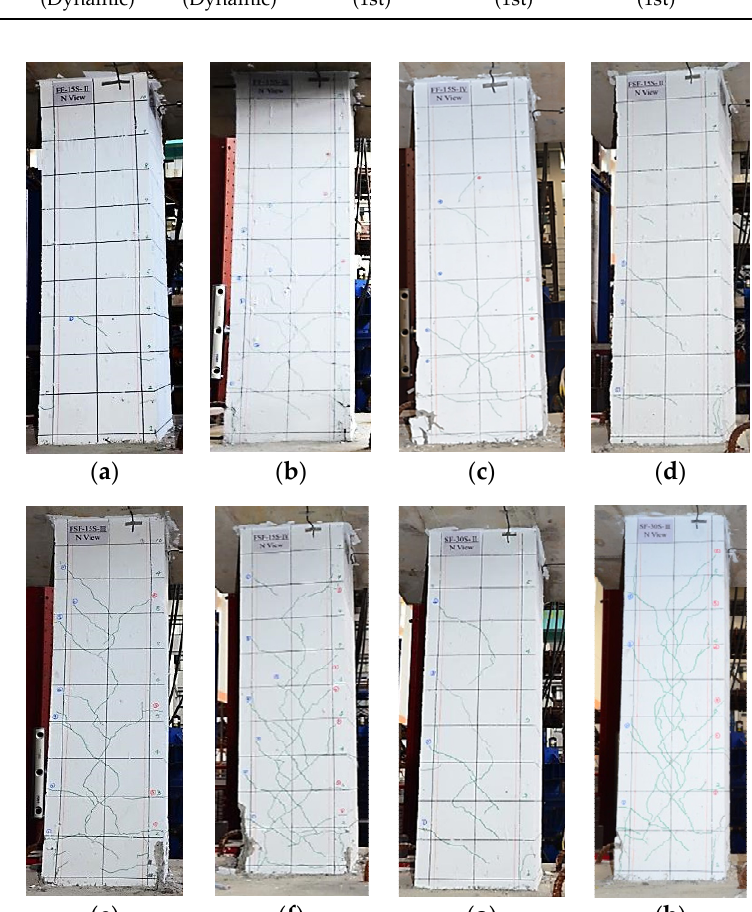
Figure 8. Relationship between lateral force and deformation of each specimen. ( a ) FF-15S-II; ( b ) FF-